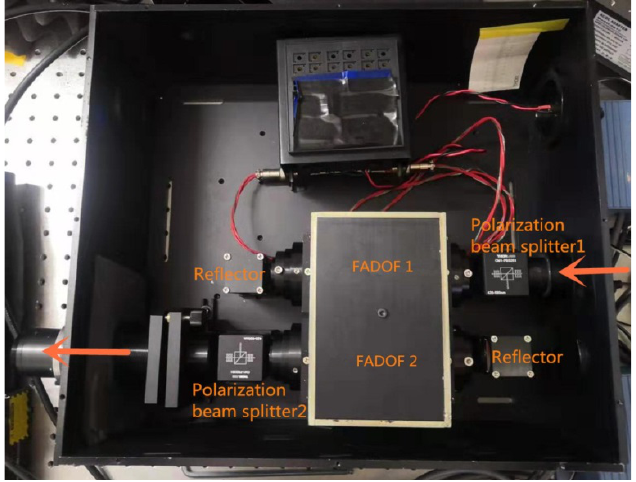
Figure 4. Dual-channel FADOF physical diagram.